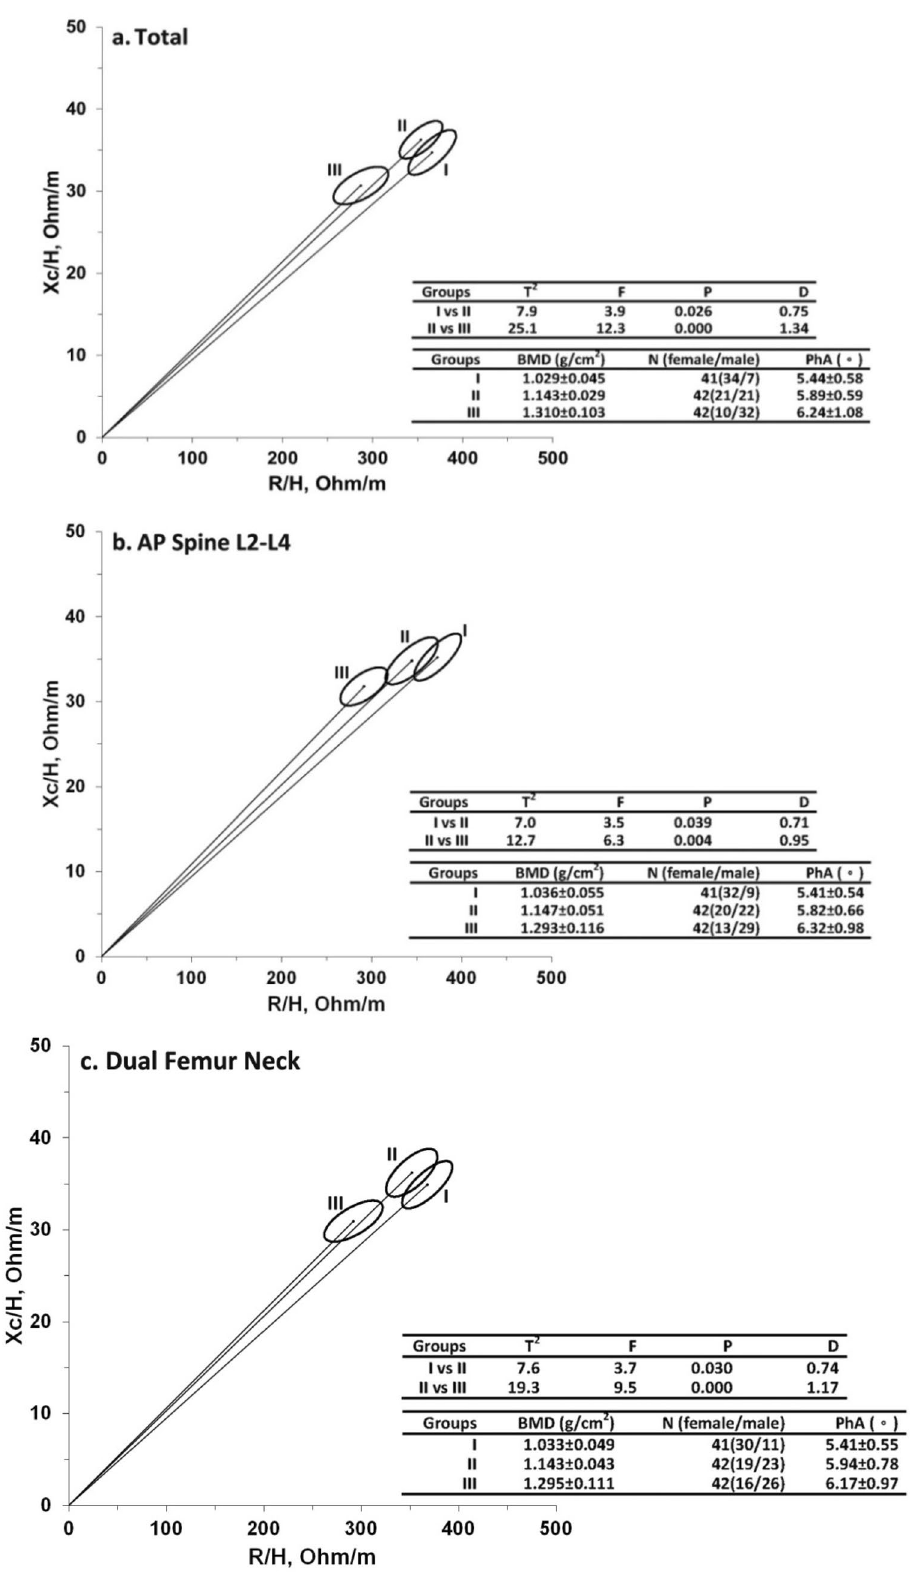
Figure 1. Mean graph with 95% confidence interval ellipse. ( a ). BMD-Total; ( b ) BMD-AP Spine L2–L4; ( c ) BMD-Dual Femur Neck; Hotelling’s T 2 test value with the corresponding F test and P values, and the Mahalanobis’ generalized distance D. PhA phase angle, Group I participants with the lowest BMD level, Group II participants with middle BMD level, Group III patients with the highest BMD